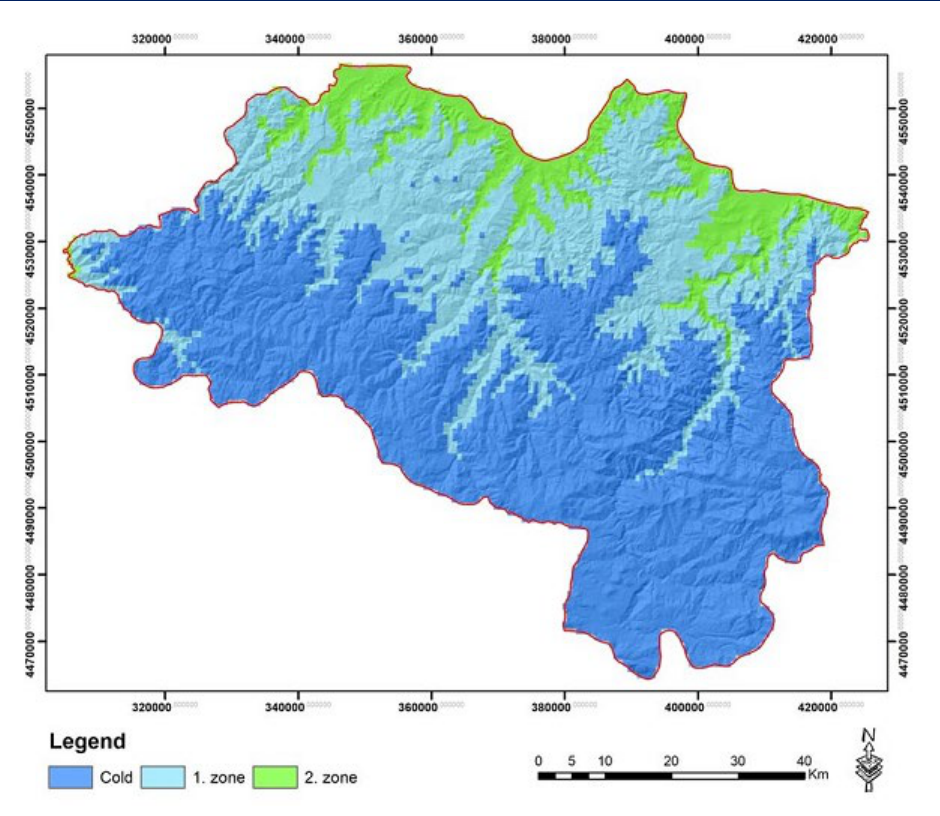
Figure 4 Comfort in Ordu Province in Summer (Alrabiti